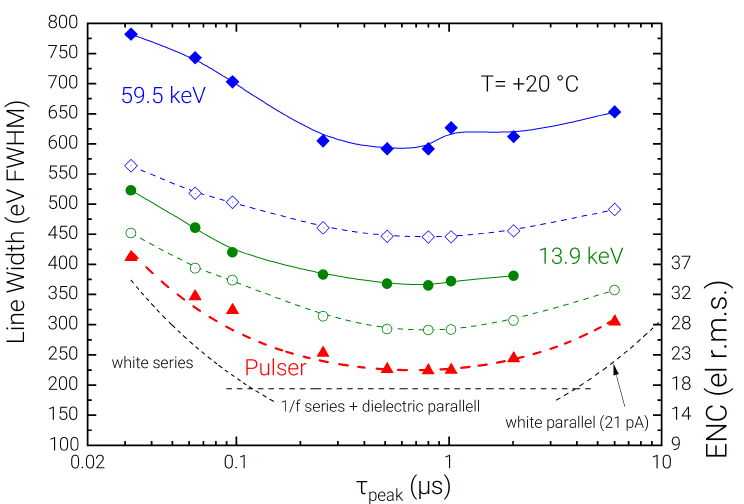
Figure 10. Line widths at room temperature of the SIRIO-CZT system with a 241 Am calibration source on the 59.5 keV and 13.9 keV lines with fast peaking-time sweep performed using Dante DPP. Solid blue and green lines are measured FWHM values, while the respective dashed lines are the expected FWHM values summing the pulser FWHM and Fano noise contribution. The estimated series and parallel noise contributions on the pulser FWHM are shown separately with dashed black lines and quadratically summed on the red dashed line. The shot noise associated with the detector current (21 pA) is shown on the bottom-right, estimated evaluating the slope (V/µs) of the ramp at the output of the CSA in absence of incoming photons